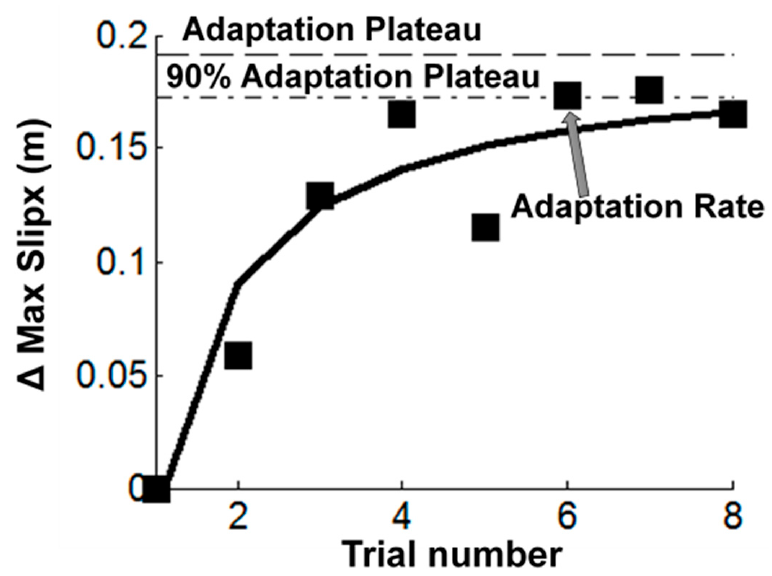
Figure 1. An example of nonlinear regression of adaptation curve for change in maximum slip displacement ( ∆ Max slipx) (m–meters) during repeated slip training (S1–S8) for a single participant. The adaptation plateau represents the best performance, which was derived from the nonlinear regression model, and the adaptation rate was defined as the number of trials required to reach 90% of the adaptation plateau. The square marker denotes the changes in slipping distance relative to S1, and the solid curve denotes the estimated adaptation curve. The dashed line denotes adaptation plateau achieved by the participant for maximum slip displacement during S1–S8. The dotted line denotes 90% of the adaptation plateau achieved by the participant for maximum slip displacement during S1-S8.